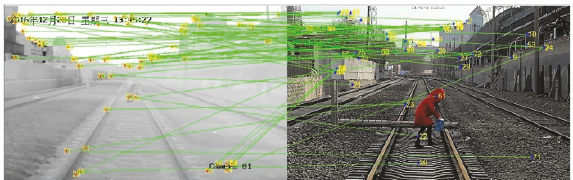
Figure 3: Initial candidate matching